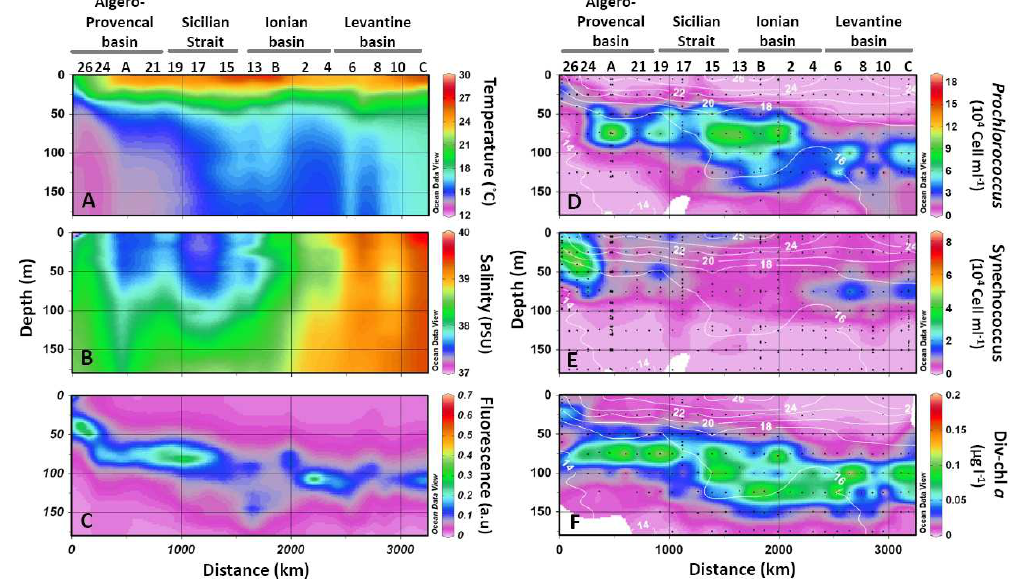
Fig. 2. Depth profiles of temperature (A) , salinity (B) , fluorescence (C) , Prochlorococcus abundance (D) , Synechococcus abundance (E) and concentration of the Prochlorococcus -specific pigment divinyl-Chl a (F) along the BOUM cruise track. For each panel, the x axis represents the cumulative distance in kilometers from a site near the French coast (43.21 ◦ N, 4.93 ◦ E) and the y axis represents depth in meters. The positions of the main marine regions are indicated at the top of the graph as well as the number (or letter) of every two stations along the transect. For figures (D) to (F) , white contour lines represent temperature in ◦ C and black dots correspond to sampled depths. Note that to better emphasize the differential distributions of Prochlorococcus and Synechococcus along the BOUM transect, different scales have been used in Fig. 2d and